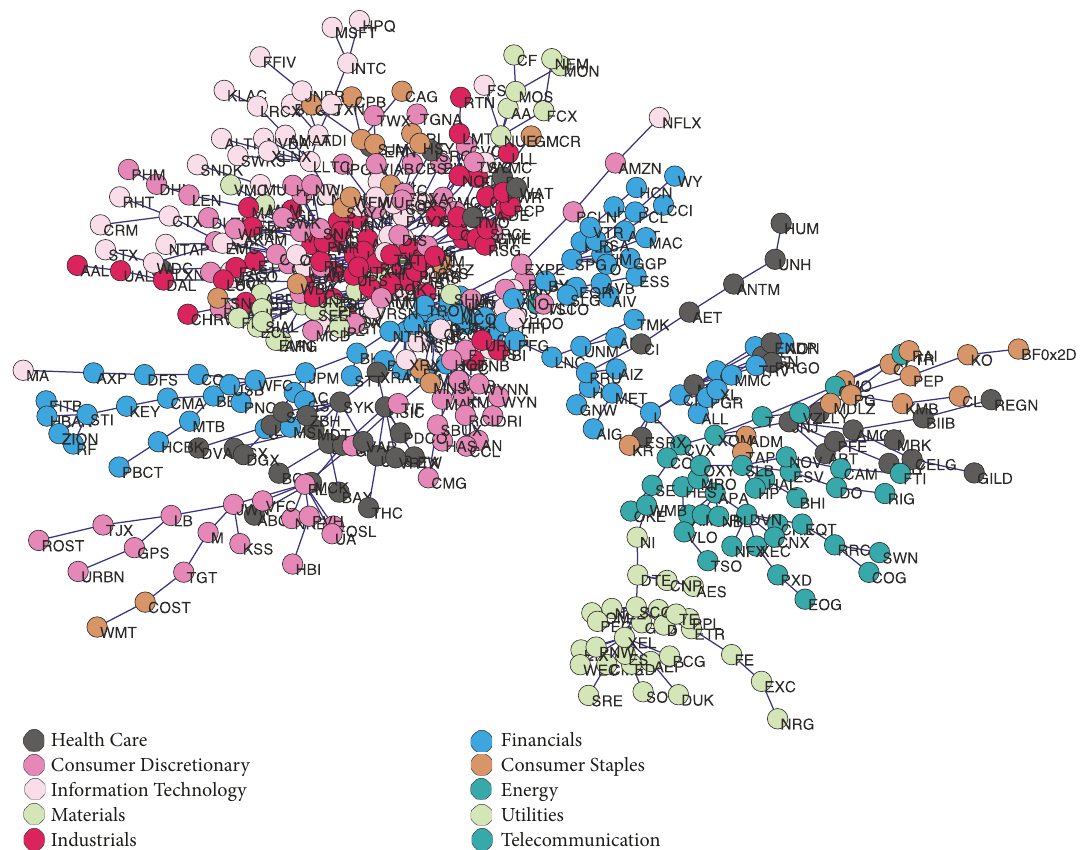
Figure 14: Minimum spanning tree of S&P468. Vertices are colored to indicate different industry sectors.